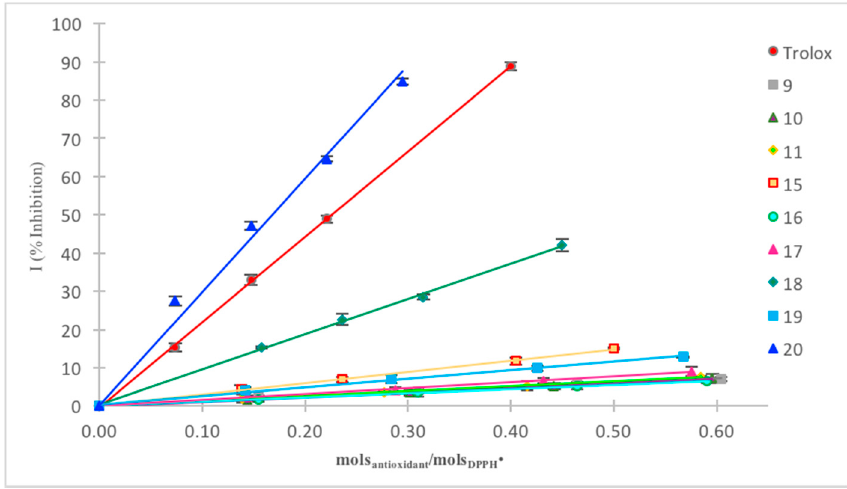
Figure 3. Regression line of the tested compounds 9 – 11 and 15 – 20 in DPPH assay in acetonitrile (ACN).